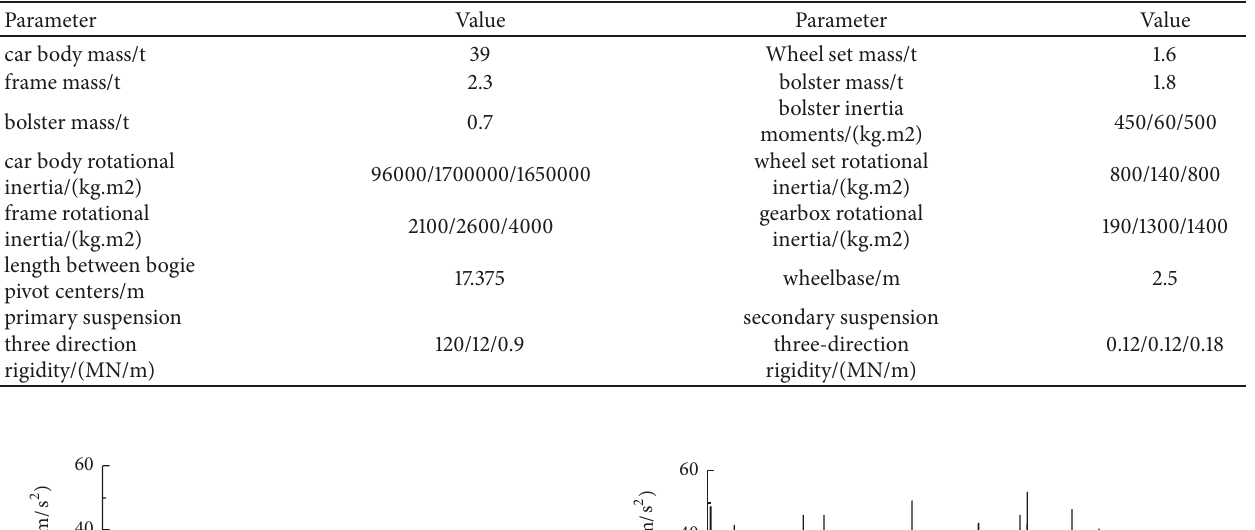
Table 3: The main parameters of vehicle.